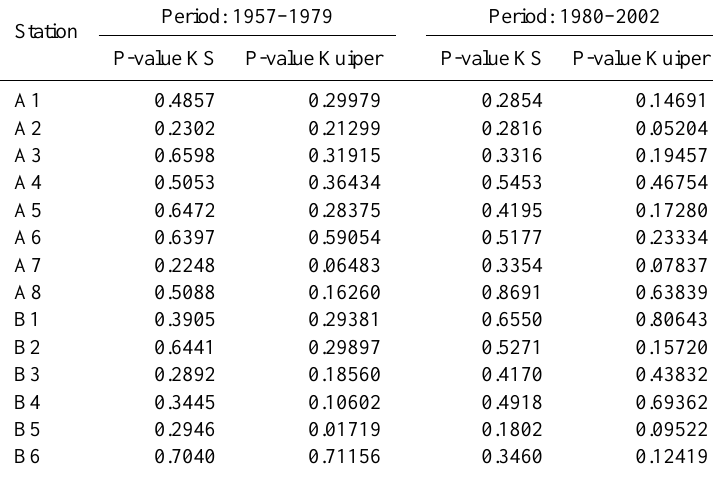
Table 5. P-values from Kolmogorov-Smirnov (KS) and Kuiper’s tests of goodness of fit to the GPD distribution for each period.